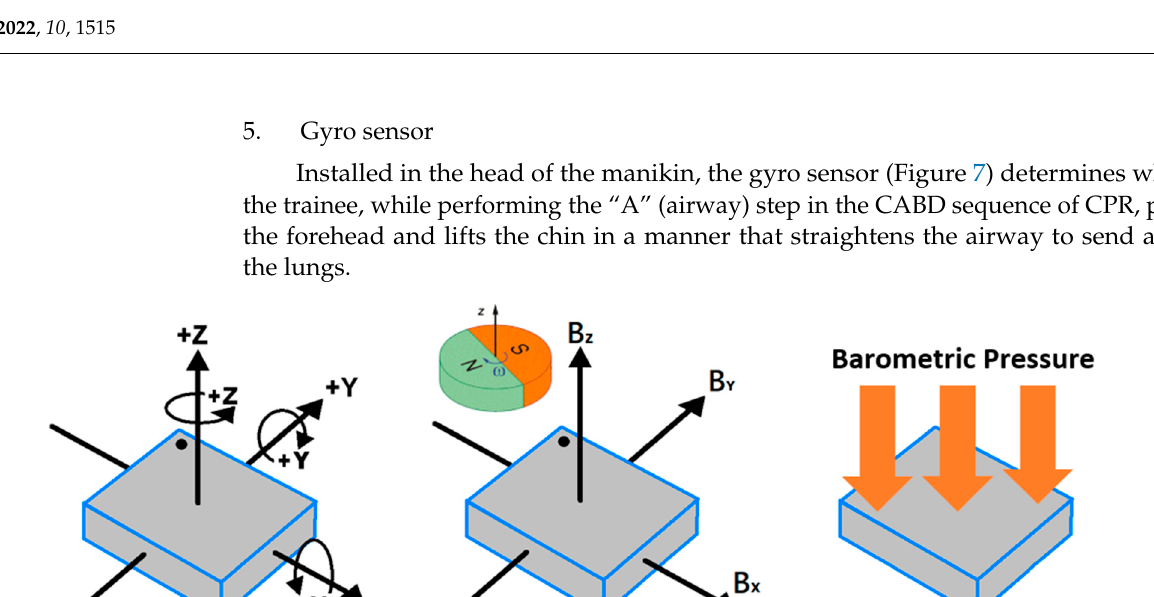
Figure 6. The pressure sensor.